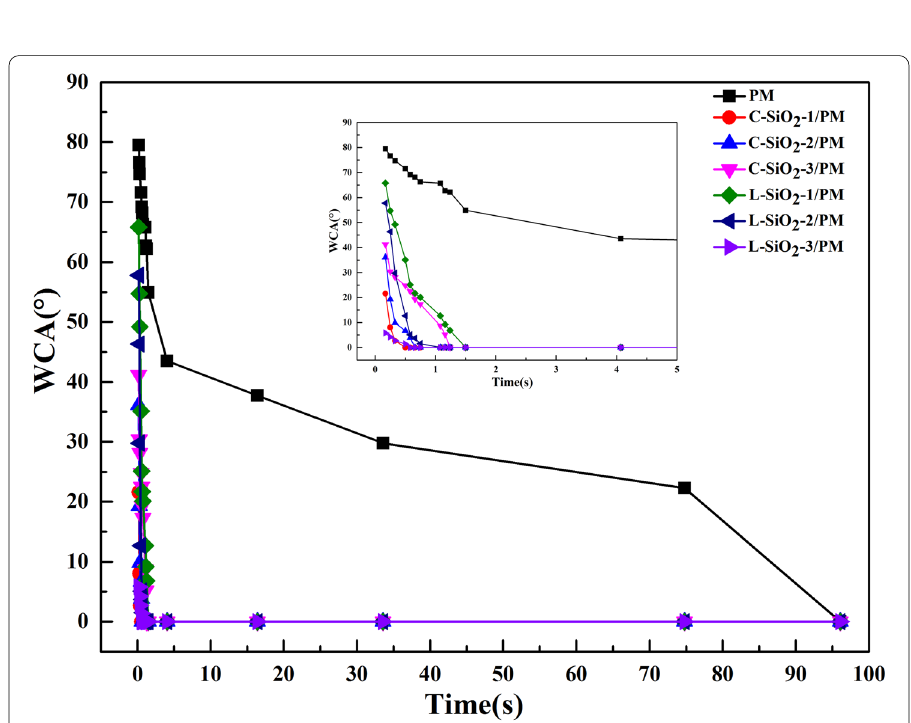
Fig. 7 WCA contact angles of PM and